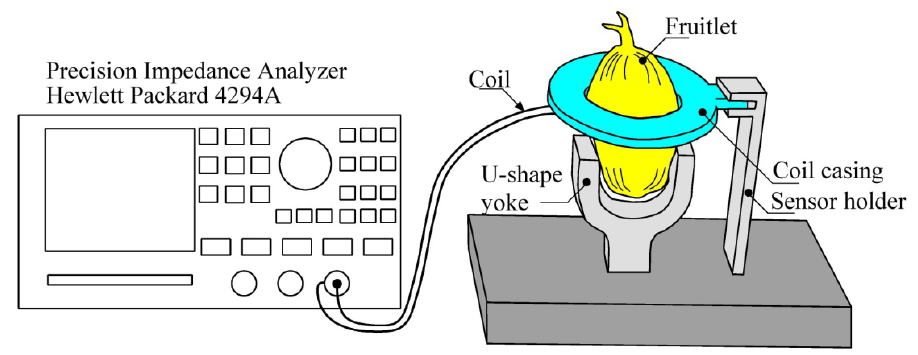
Figure 5. Frequency characteristics experimental setup.